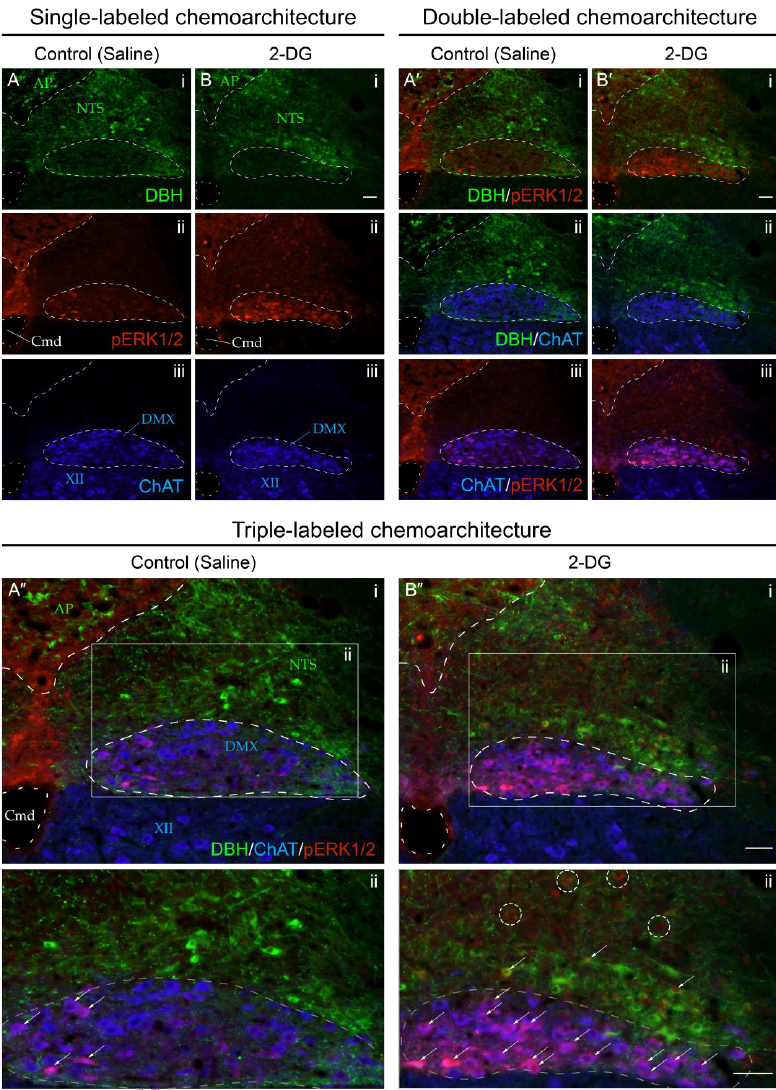
Figure 9. Increased recruitment of dorsal medulla (Winslow, 1733) [42] (MY) neurons 15 min after intravenous 2-deoxy- D -glucose (2-DG) administration relative to saline-treated subjects. Single-channel ( A , B ), dual-channel ( A’ , B’ ), and triple-channel ( A” , B” ) coronal-plane images, from saline- (( A , A’ , A” ); Subject K10-007) and 2-DG-treated ( B , B’ , B” ); Subject K10-027) subjects, of individual immunoreactivity patterns for dopamine β -hydroxylase (DBH; green ), phospho-ERK1/2 (pERK1/2; red ), and choline acetyltransferase (ChAT; blue ) in the area postrema (>1840) (AP), nucleus of solitary tract (>1840) (NTS), dorsal motor nucleus of vagus nerve (>1840) (DMX), and hypoglossal nucleus (>1840) (XII), in the vicinity of the central canal of medulla (>1840) (Cmd). Individual single-channel images are shown in ( A , B ) for DBH signal (( Ai , Bi )), phospho-ERK1/2 signal ( Aii , Bii ), and ChAT signal ( Aiii , Biii ). Similarly, pairs of signals are shown in dual-channel images in ( A’ , B’ ): DBH with phospho-ERK1/2 ( A’i , B’i ), DBH with ChAT ( A’ii , B’ii ), and ChAT with phospho-ERK1/2 ( A’iii , B’iii ). Finally, triple-channel images of all signals combined (DBH, phospho-ERK1/2, ChAT) are shown in ( A”i , B”i ), with enlargements of the boxed areas designated as ( A”ii , B”ii ), respectively, with perikaryon profiles dual-labeled for phospho-ERK1/2 and either DBH or ChAT marked by arrows . Note that the AP and NTS labels are colored green to signify their boundary determinations using the pattern of immunoreactivity observed for DBH in the green channel, and DMX and XII locations are labeled in blue to signify their boundary determinations using the ChAT immunoreactive signal in the far-red channel. See the methods section for more details. Phospho-ERK1/2 immunoreactivity ( red ) is also present in NTS perikaryon profiles of unidentified phenotype (see dashed circles in ( B”ii )) in 2-DG-treated but not saline-treated